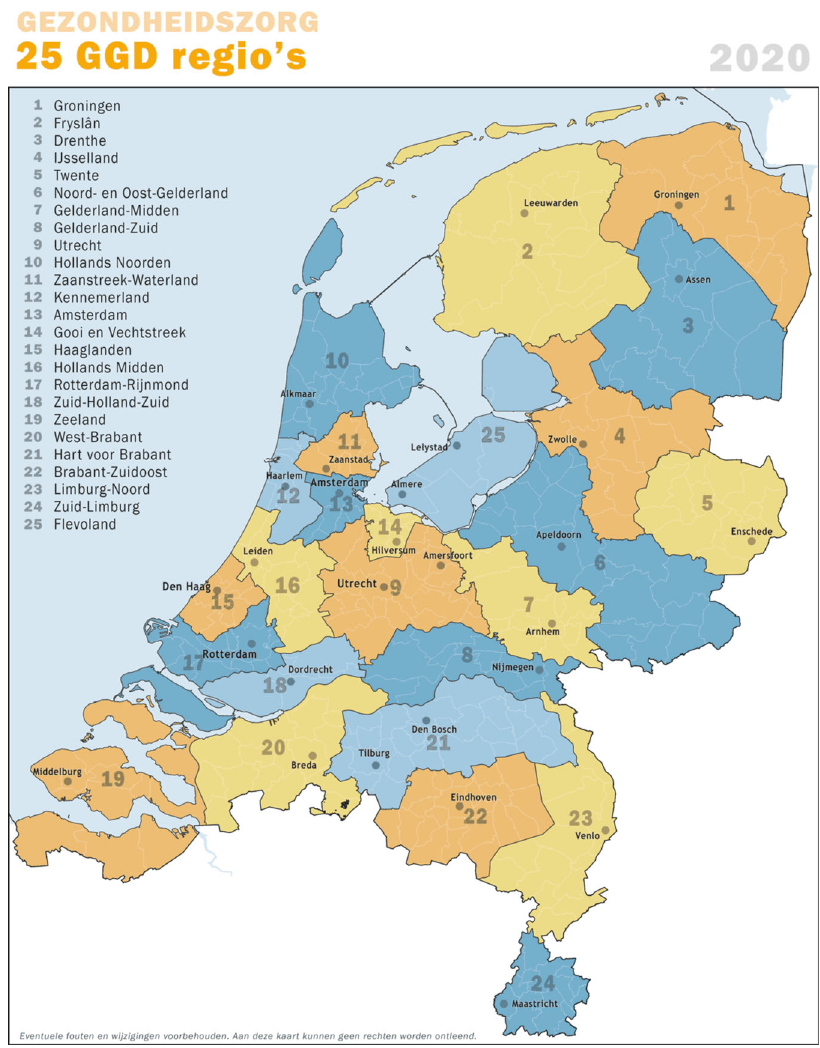
Fig. 1 The 25 GGD Municipal Health Service regions in the